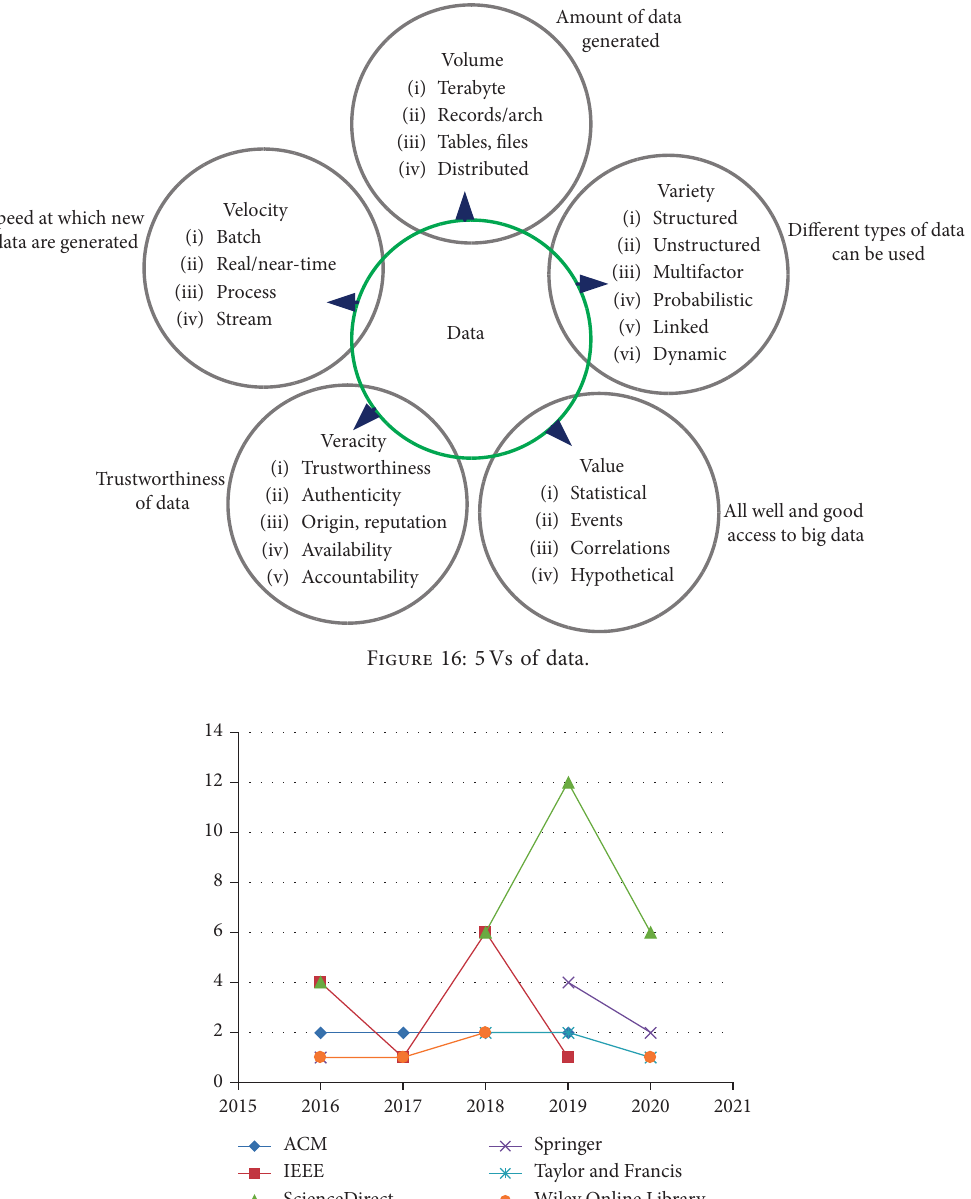
Figure 17: Number of publications in given years and